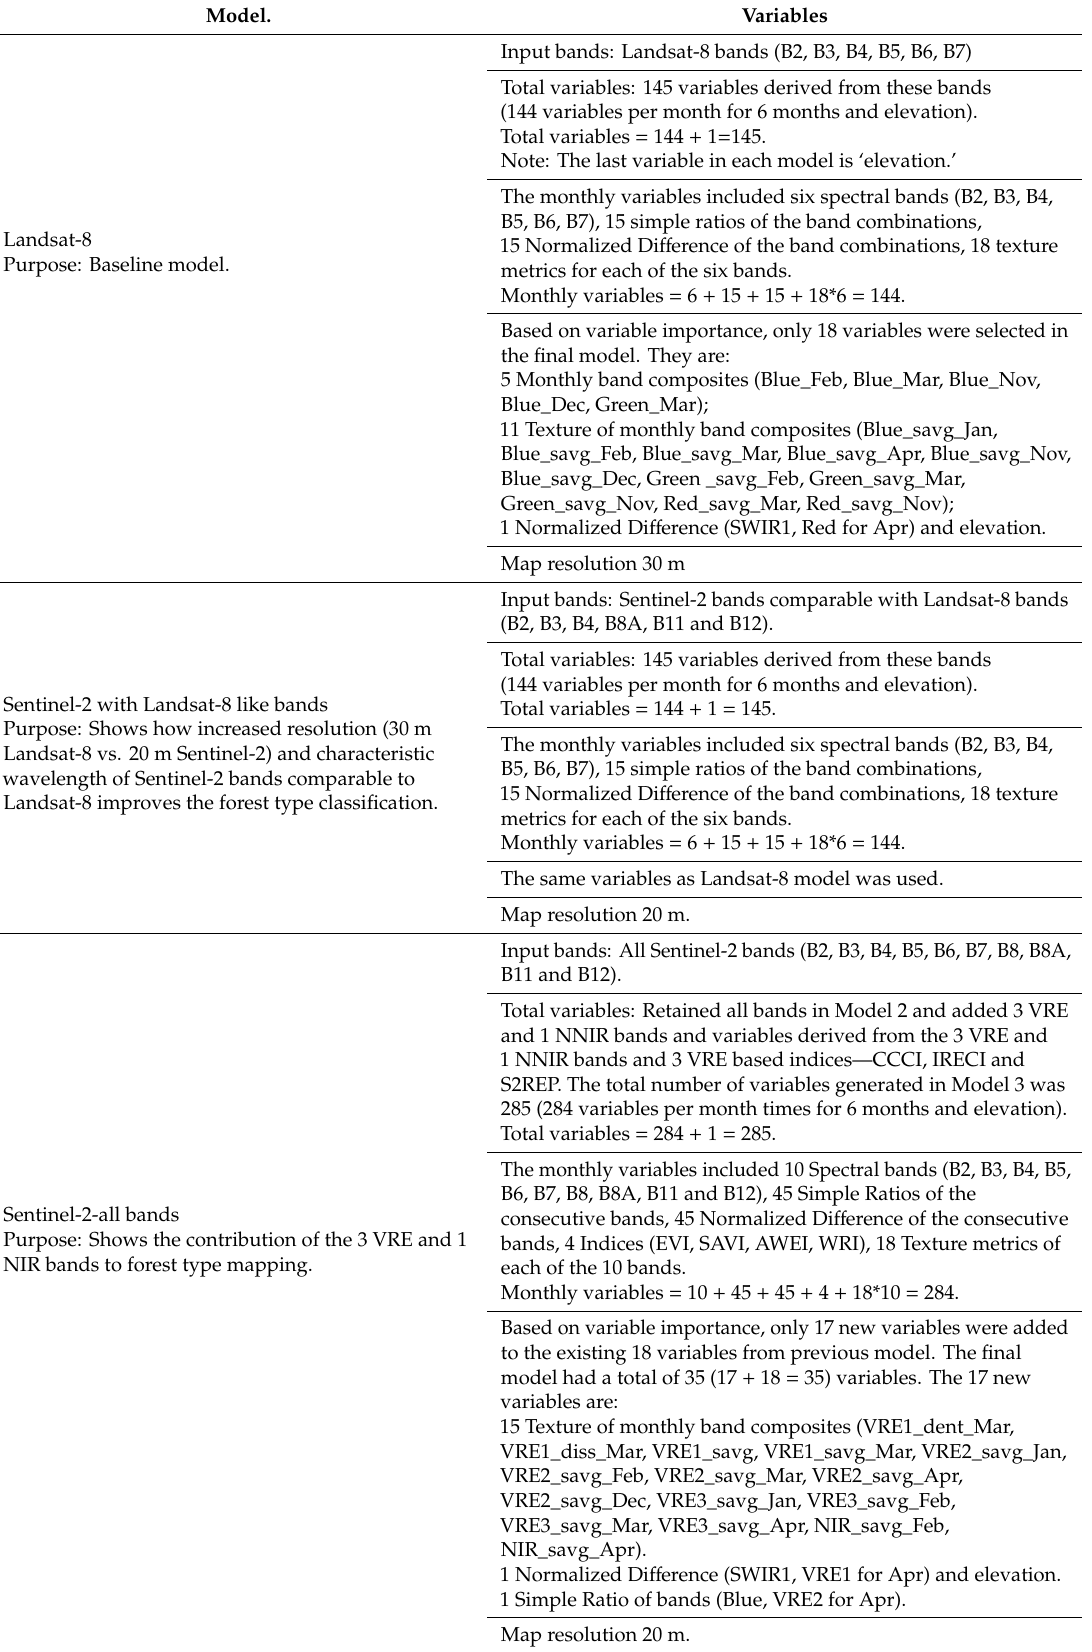
Table 2. Sensors and band combinations used for each